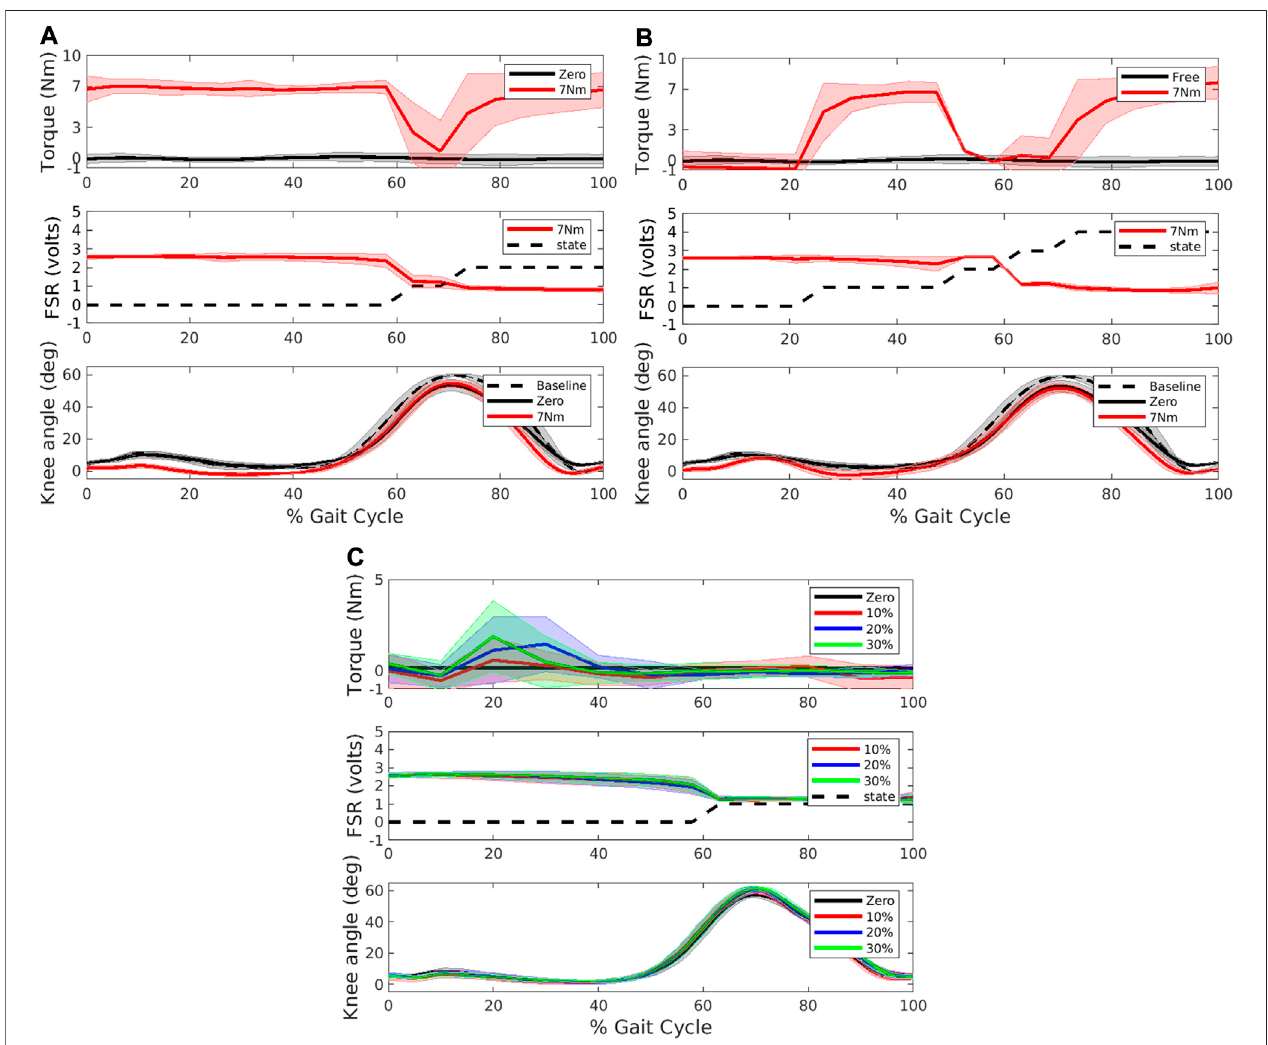
FIGURE 4 | Torque (top panel), force sensitive resistor (FSR) and state number (middle panel) and knee angle (bottom panel) collected during the different exoskeleton modes during overground walking in a participant with typical development. Constant mode was evaluated with a (A) 3-state FSM and (B) 5-state FSM. In the torque and angle subplots, dashed black line represents baseline walking without the exoskeleton, black line represents Zero mode, and red line represents the respectiveConstantmodewith7 Nmassistancetorque,respectively.IntheFSRsubplot,dashed blacklinerepresentsstatelevelateachpoint ofgaitcycle.For3- state, level 0 represents stance phase, level 1 early swing, level 2 late swing. For 5-state, level 0 represents early stance phase, level 1 mid-stance, level 2 late stance, level3earlyswing,andlevel4lateswing. (C) Adaptivecondition.BlacklinerepresentsZeromode,red,blueandgreenlinesrepresentextensionassistancesetat10,20, and 30 percent of estimated biological knee moment, respectively. In the FSR subplot, dashed black line represents state level (0 represents stance, and 1 is swing).